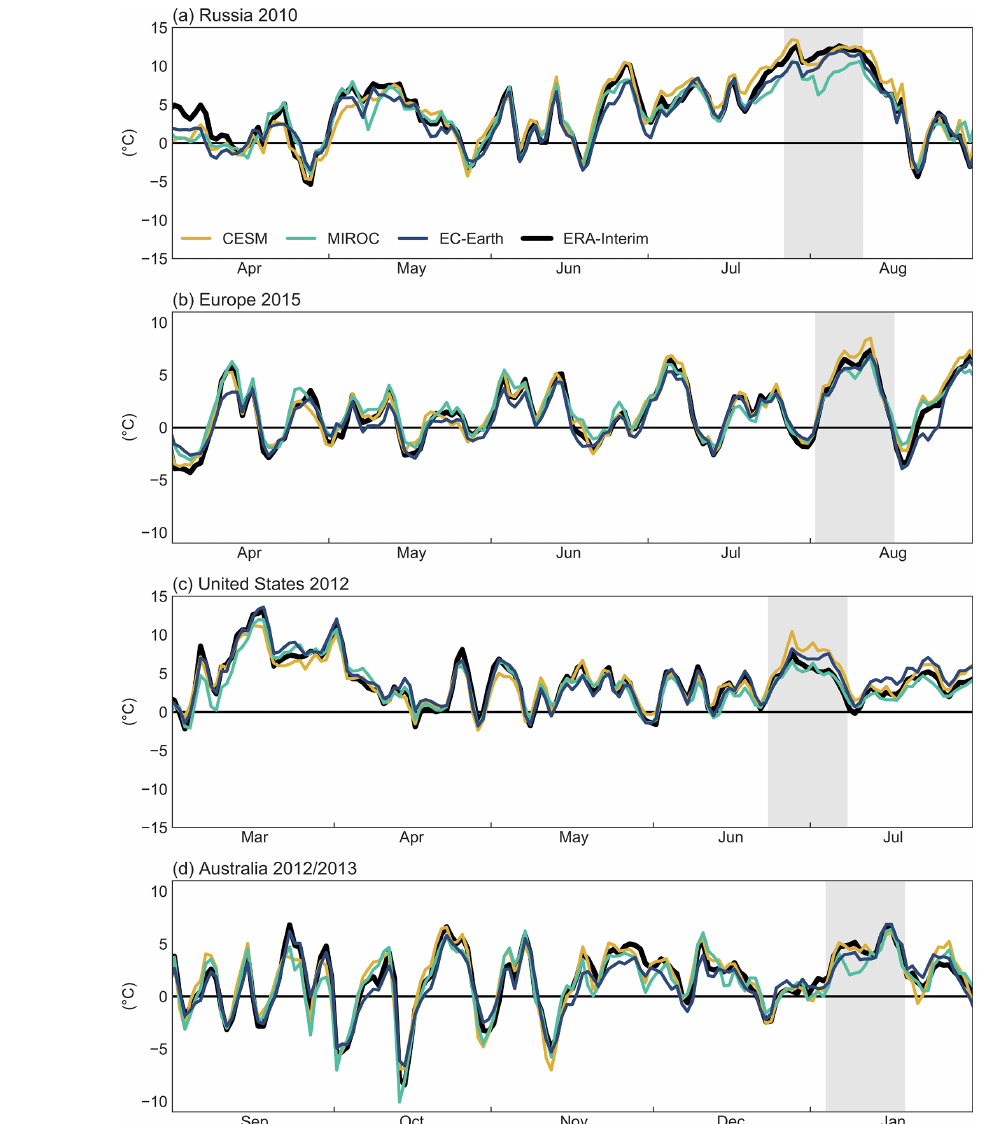
Figure 6. Daily maximum temperature anomaly compared to the 1982–2008 climatology for the fully constrained (AF_SF) experiment for the three models and for ERA-Interim (black line). The 15d event period is highlighted in light